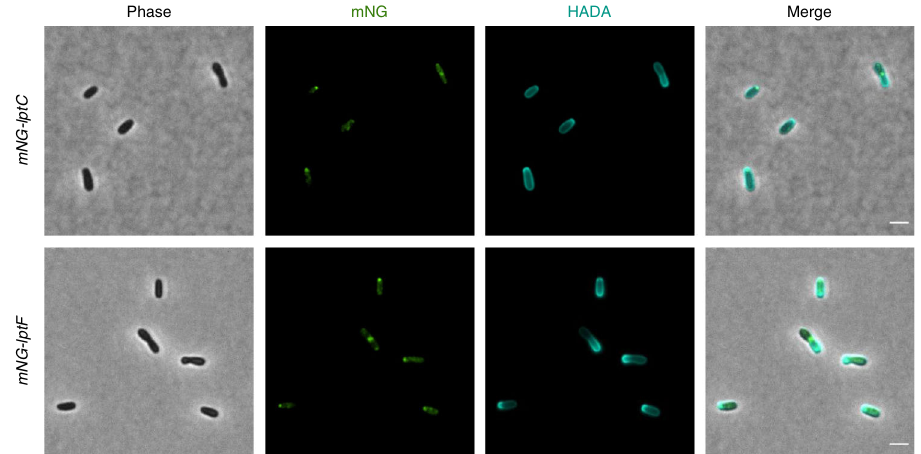
experiment was performed three times for each strain, giving similar results. Scale bar represents 2 µ m. Source data are provided as a Source Data fi le.